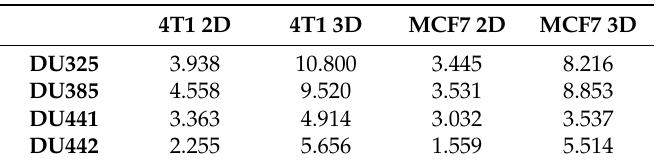
Table 2. IC 50 values ( µ M) of analogs on 4T1 and MCF7 breast cancer cells determined by resazurin assay upon treatment by imidazo[1,2- b